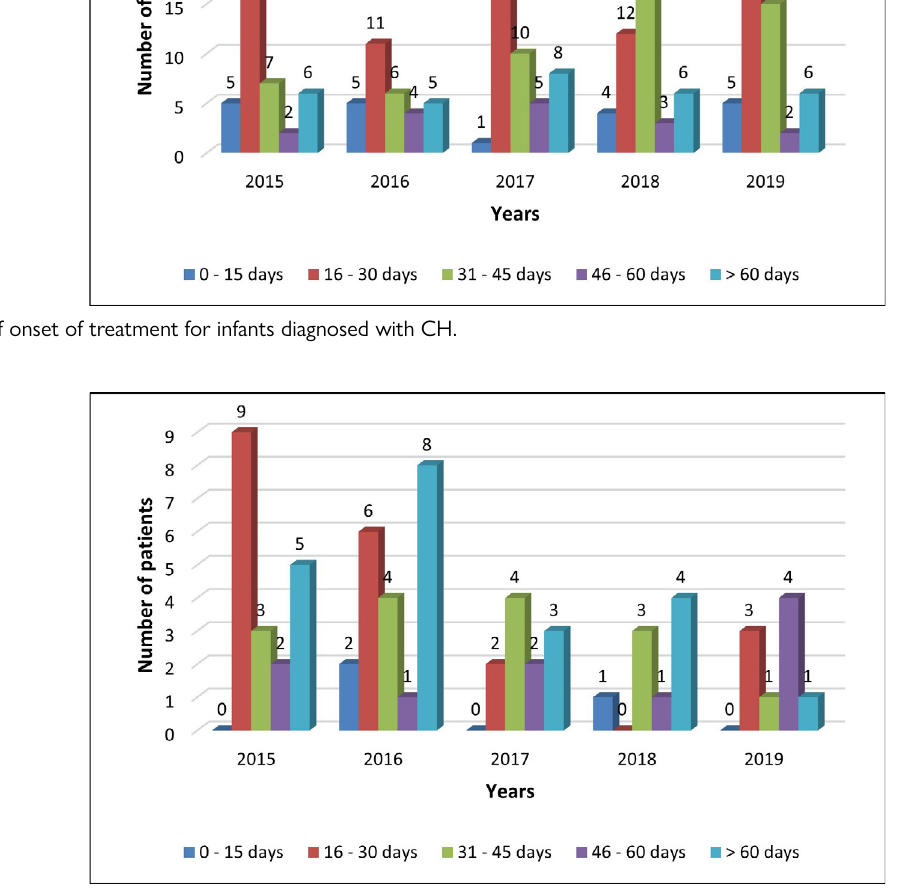
Figure 7. Age of onset of treatment for infants diagnosed with HPA/PKU.